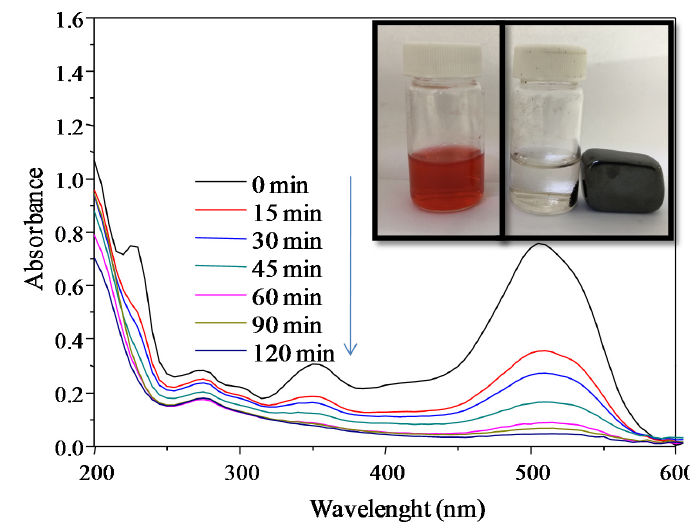
Figure 10. UV-Vis absorption spectra for Acid Red 66 at different time intervals under visible light irradiation for FeC composite. The included Figure is the picture of the dye solution before (0 min) and after (120 min) adsorption processes.